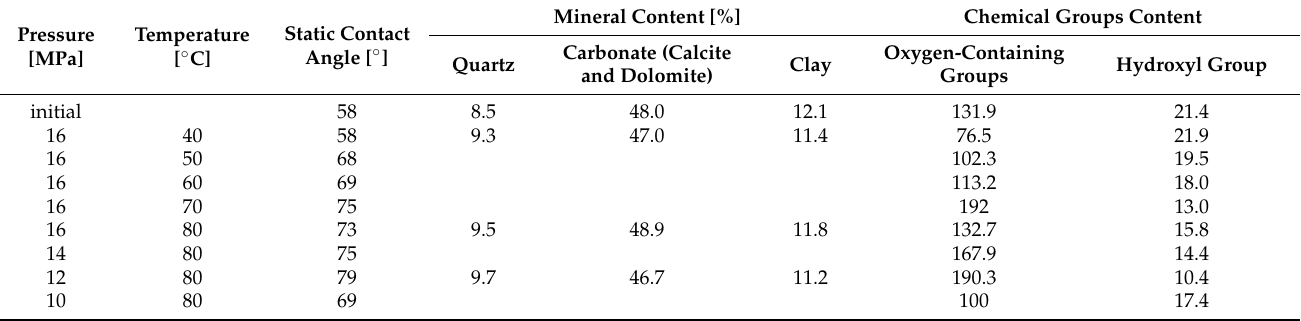
Table 2. Changes of shale under different temperatures/pressures after shale reacted with CO 2 for 10 d